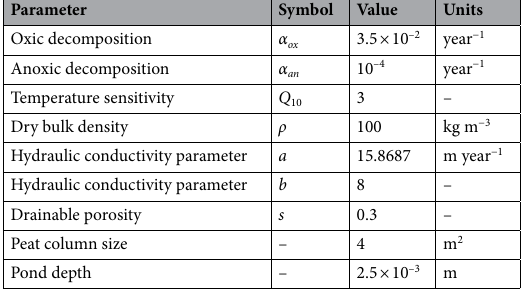
Table 1. Model parameter